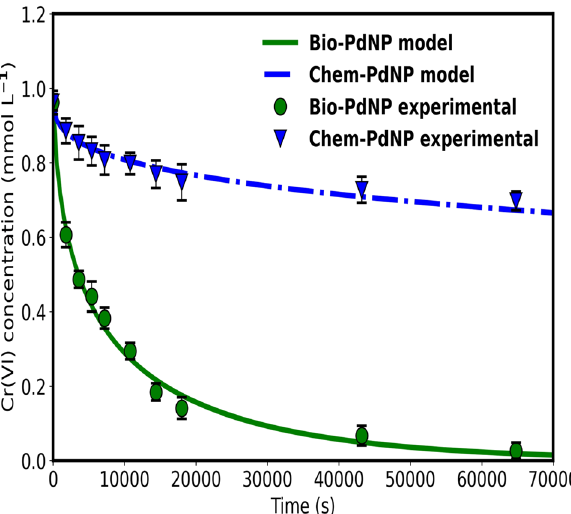
Figure 8. A comparison between predicted model values and experimental data for catalytic Cr(VI) reduction using Bio-PdNPs and Chem-PdNPs.